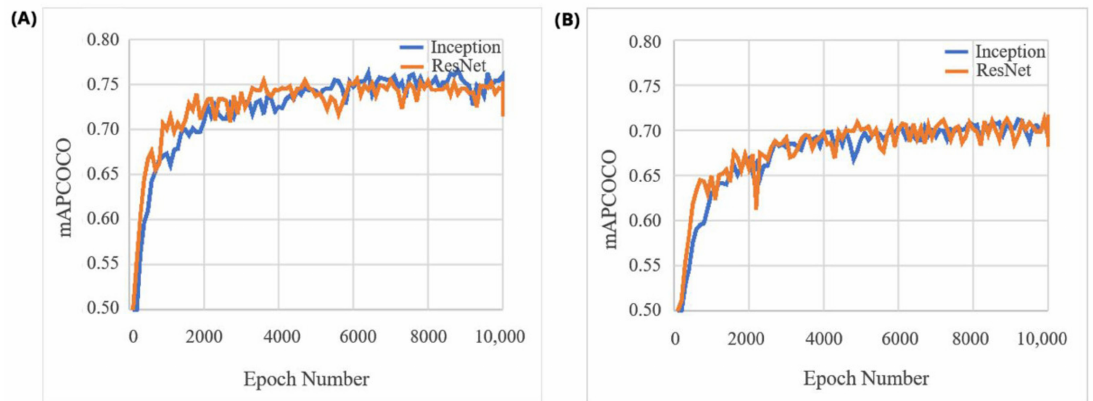
Figure 12. mAP COCO scores of the Inception-v2 and the ResNet50 models on mung bean ( A ) and chickpea ( B ) validation dataset during the training process.